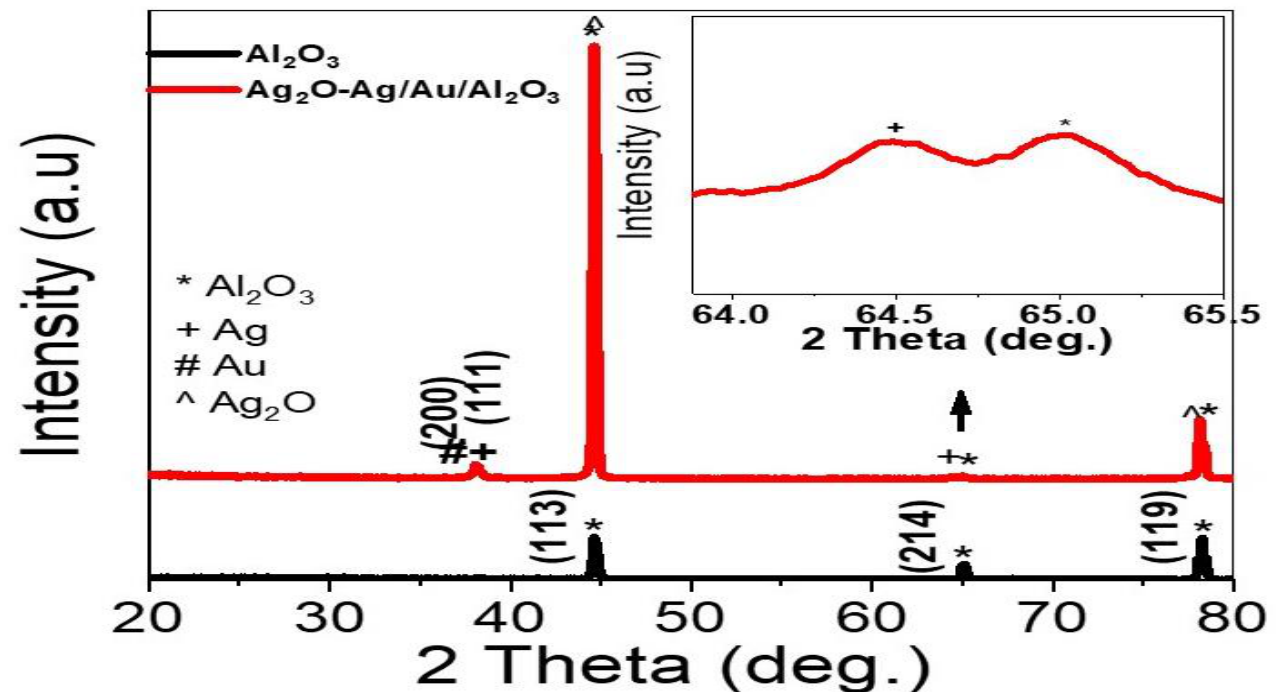
Figure 2. The XRD of Al 2 O 3 template and Ag 2 O-Ag/Au/Al 2 O 3 nanomaterial.